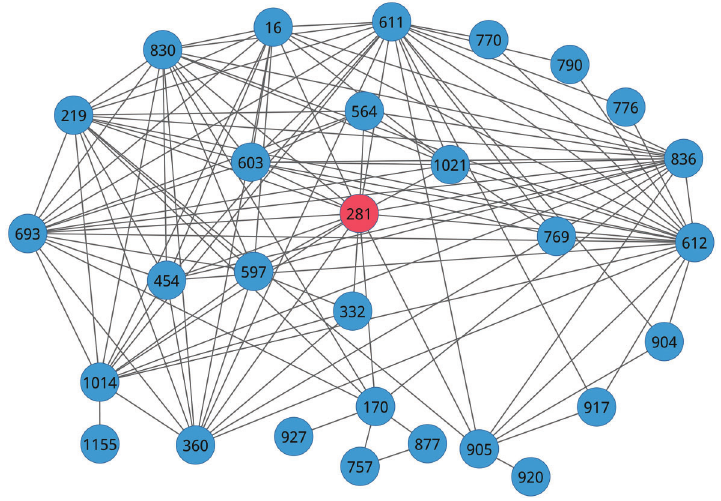
Figure 3. Dysregulated pathway interaction net- work in colorectal cancer. The 30 dysregulated pathways were assembled into a network accord- ing to the interactions. Each node represents a pathway. The orange node represents the seed pathway. Blue nodes are the dysregulated path- ways interacted with the seed pathway. The num- bers represent the pathway IDs de fi ned based on alphabetical